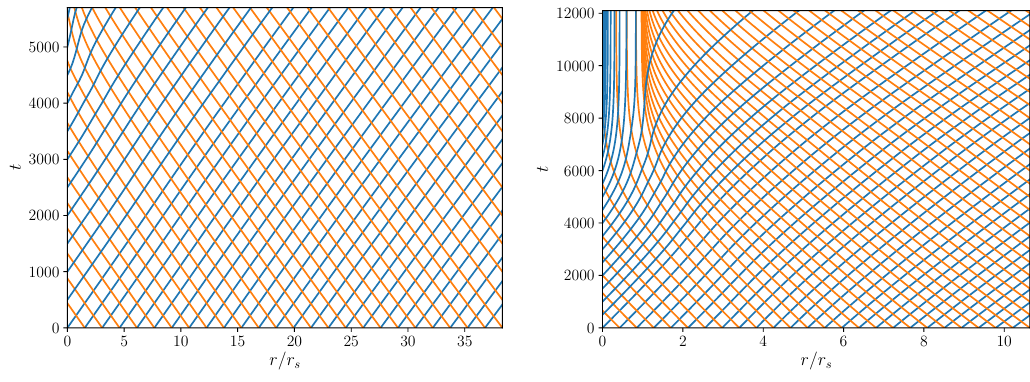
Figure 4 . Integral curves of the ingoing (orange) and outgoing (blue) characteristic speed c (cid:6) de(cid:12)ned by eq. (4.2) for (cid:12) = 5 and gaussian initial conditions. In the left panel, (cid:30) 0 = 3 : 5 10 (cid:0) 6 and therefore the solution belongs to the (cid:12)rst branch, where we have formation of only the sonic horizon. In the right panel, (cid:30) 0 = 8 10 (cid:0) 6 and therefore it belongs to the last branch where a black hole forms.